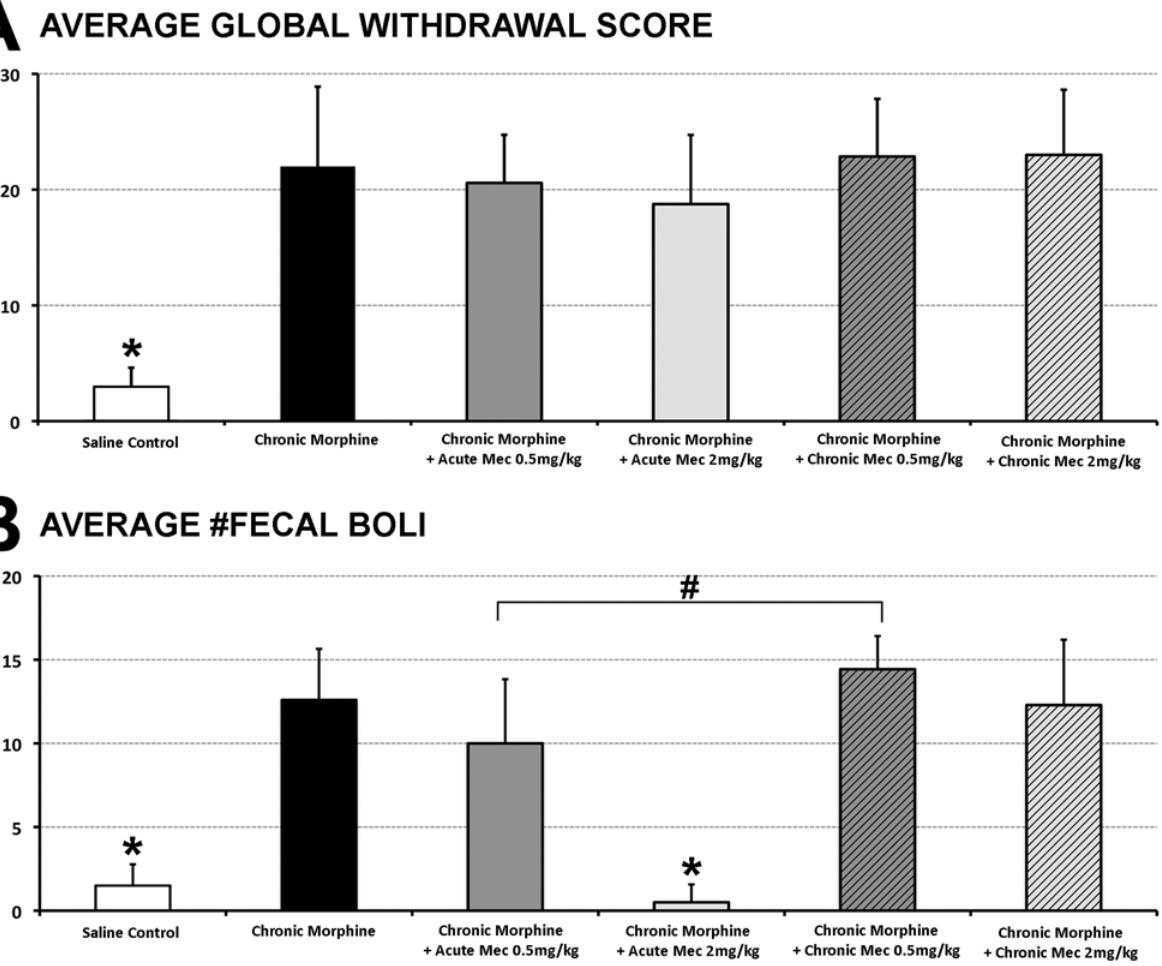
Fig 5. Behavioral Analysis of Rat Morphine Withdrawal. Panel A graph illustrates average global withdrawal score ± SD. It is significantly higher ( F (5,38) = 22.40; p < 0.001) following chronic morphine administration (n = 5) in comparison to saline control group (n = 10). However, it was not different from either acute mecamylamine ( Mec ) (n = 7 for 0.5 mg/kg dose; n = 8 for 2 mg/kg dose group), or chronic Mec groups (n = 7/group). (B) There were no differences in average number of individual behaviors among groups (not shown), except for the average number of fecal boli (#fecal boli/animal/30 min withdrawal ± SD; F (5,38) = 41.068, p < 0.001). Only 2 mg/kg acute dose of Mec significantly decreased average diarrhea following chronic morphine administration (p < 0.001) to a saline control level. Although average number of fecal boli is significantly decreased following 0.5 mg/kg acute dose of Mec in comparison to its chronic application (p < 0.003), it was still not different from chronic MSO 4 group. One-way ANOVA with LSD post-hoc test. * , statistically different from all other groups except each other; #, statistical difference only between marked